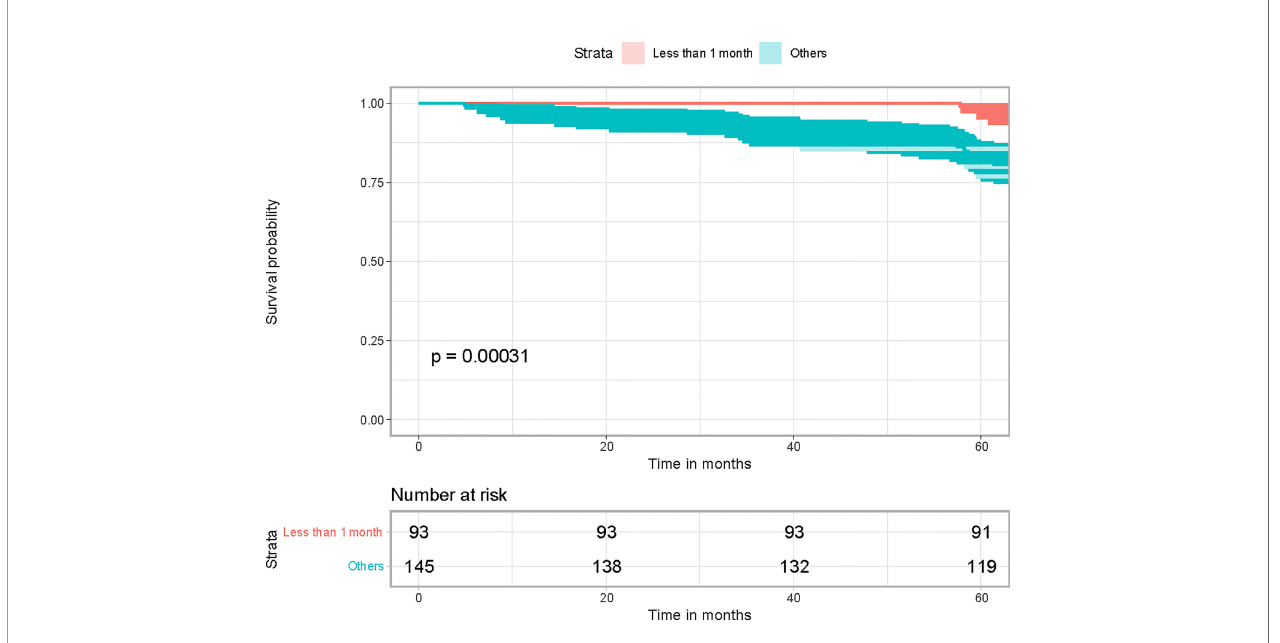
FIGURE 1 | Kaplan – Meier survival analysis